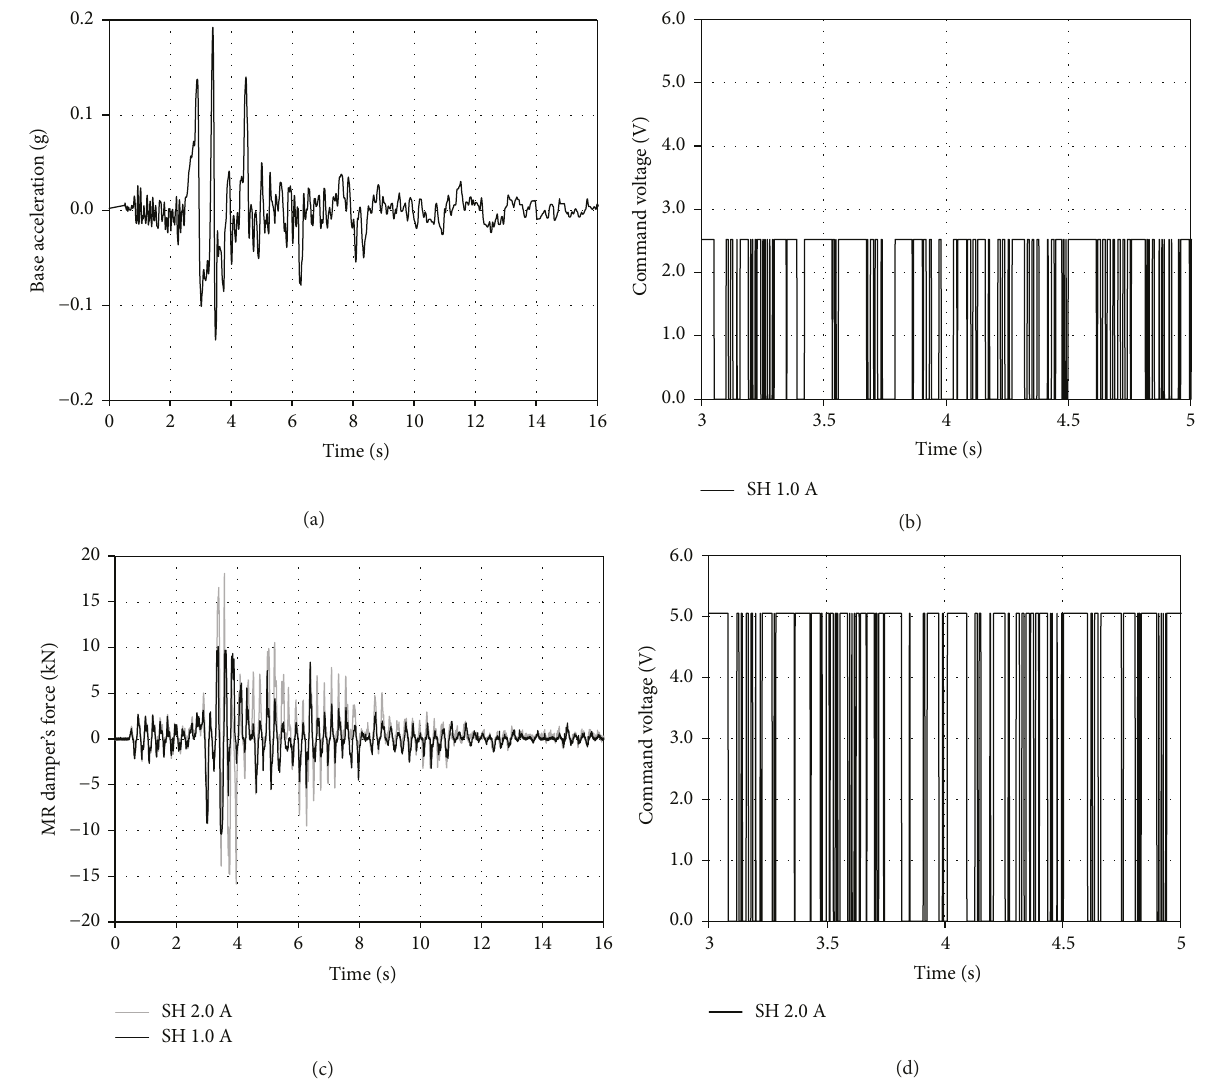
Figure 11: SA tests: registration of base acceleration (a), command voltage (b, d), and damper’s reacting force (c).